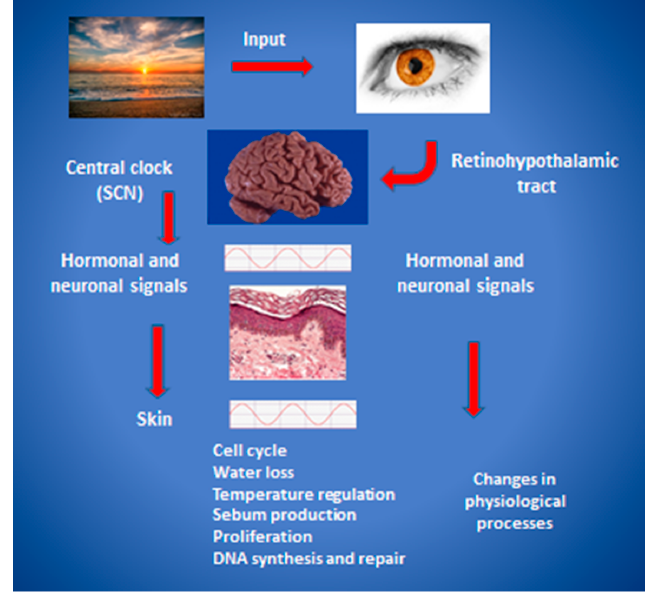
Figure 1. A model of hierarchical regulation and organization of the mammalian circadian clock. Light enters the retina and stimulates signaling via the retinohypothalamic tract to entrain the suprachiasmatic nucleus (SCN), located in the anterior hypothalamus. Hormonal and neuronal intermediaries then induce modulations of peripheral transcriptional and posttranslational responses that ultimately produce behavioral, metabolic, and physiologic output. The skin and its appendages are the focus in this figure, and key aspects of circadian regulation of physiological processes in the skin are listed. Modified from [7] with permission.